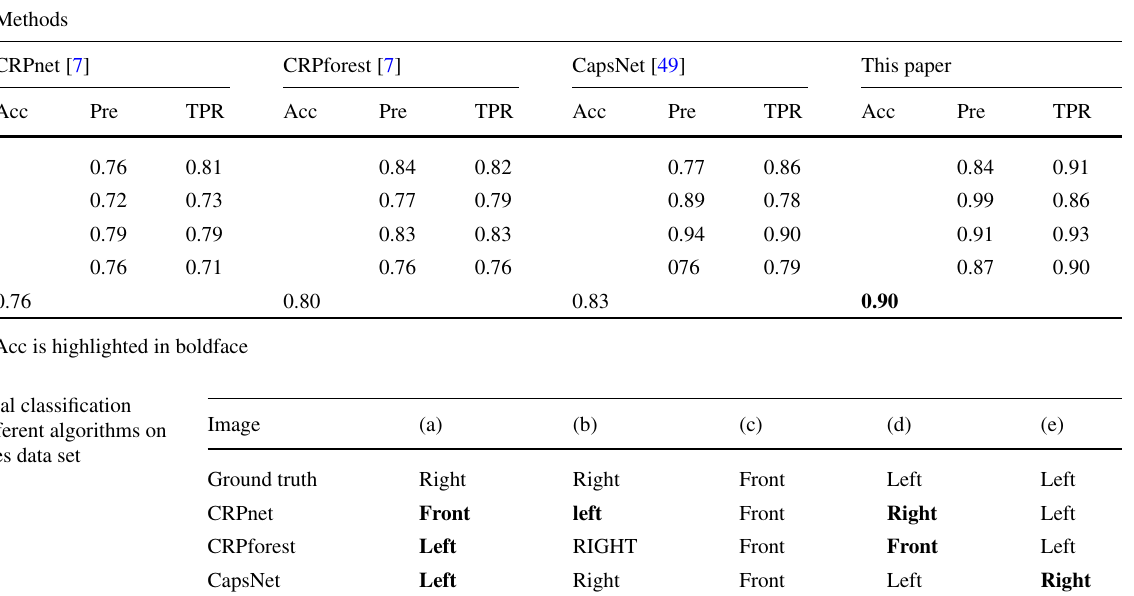
Table 6 Performance comparison of different algorithms on the Cityscapes data set